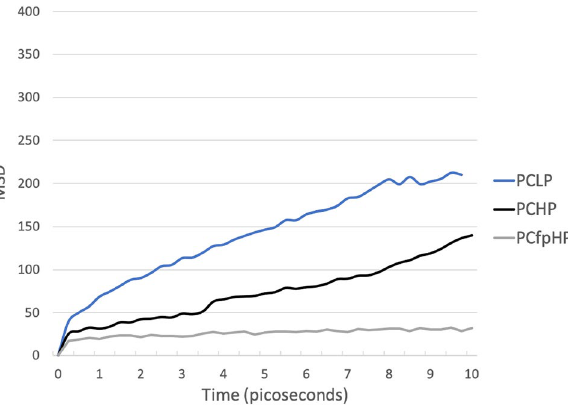
Fig. 17 Diffusion of Na + ions through low-pressure